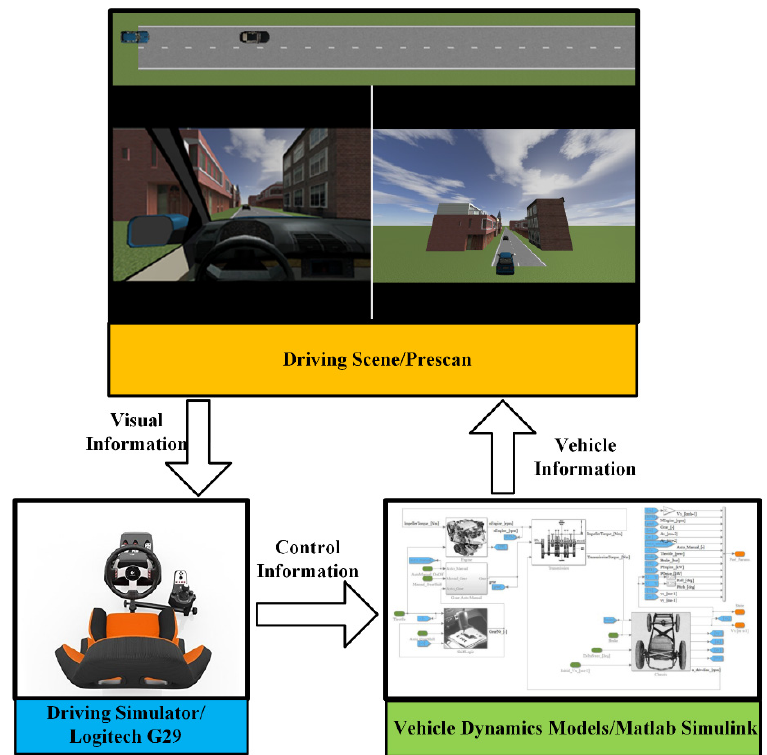
Figure 2. Driving simulator used for the experiment. Table 1. Parameters for PBLS.